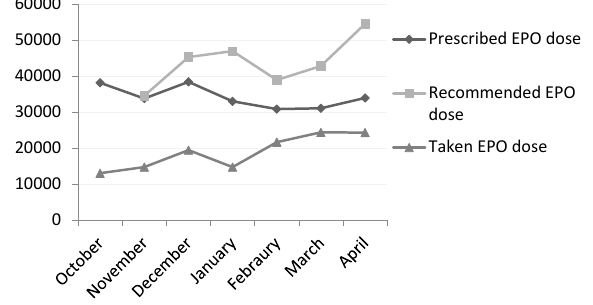
Figure 4. Comparison between prescribed, recommended and taken EPO dose.